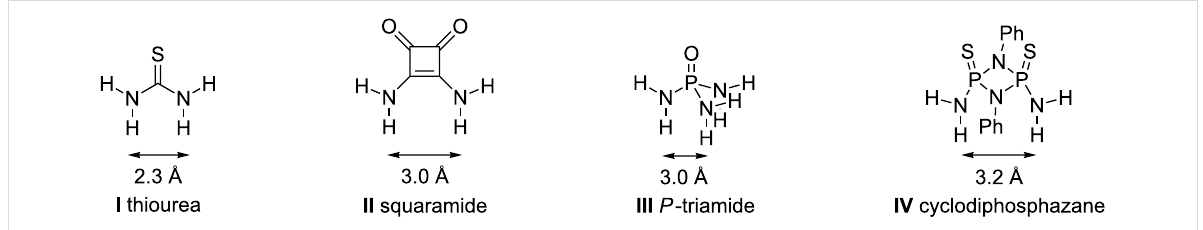
Figure 1: Thiourea, squaramide, P -triamide and cyclodiphosphazane with computed distances between H-atoms.